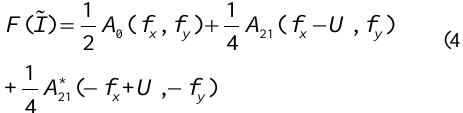
Compared with Eq. (2), the extra S 3 term in Eq. (8) will cause reconstruction error in S 0 and affect the demodulation accuracy of S 1 and S 2 .